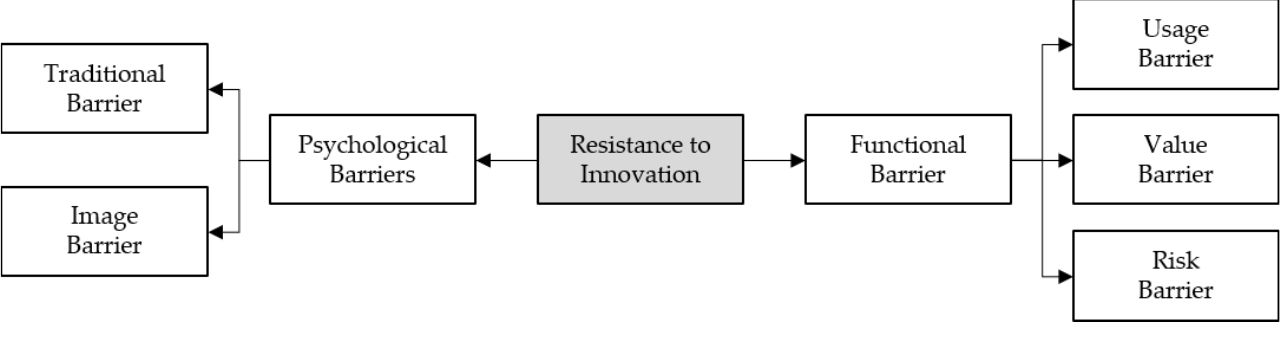
Figure 2. Innovation resistance.